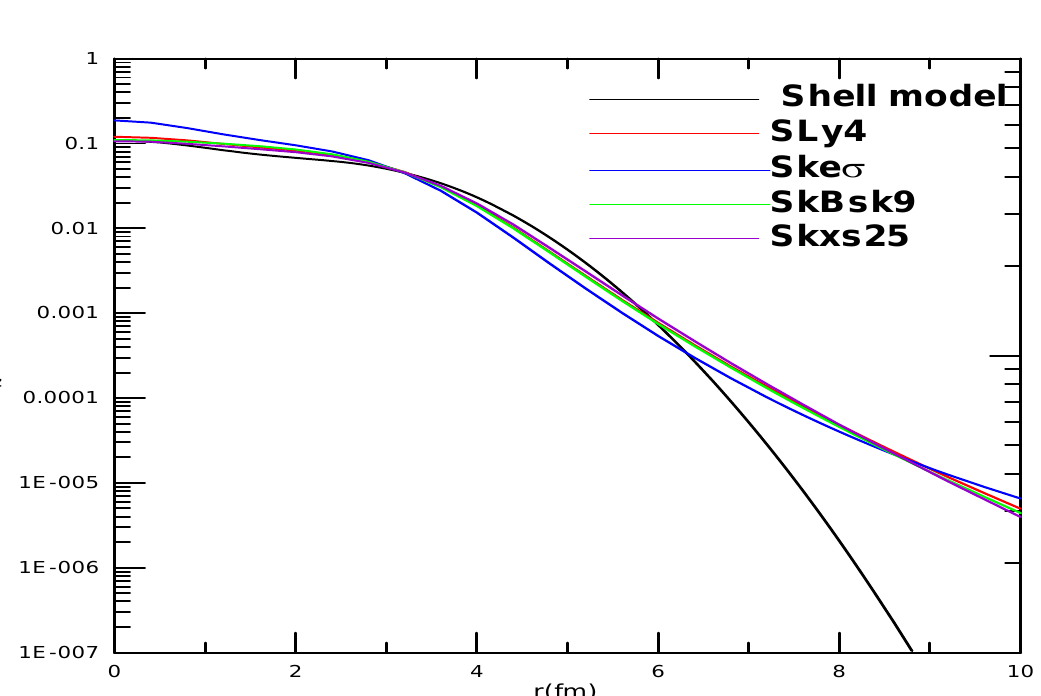
Fig.7: Neutron density distributions of 25 F .